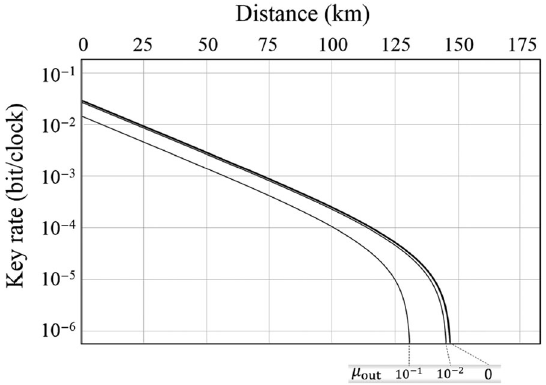
~ R (cid:4) versus distance for the decoy- . Parameters in the out